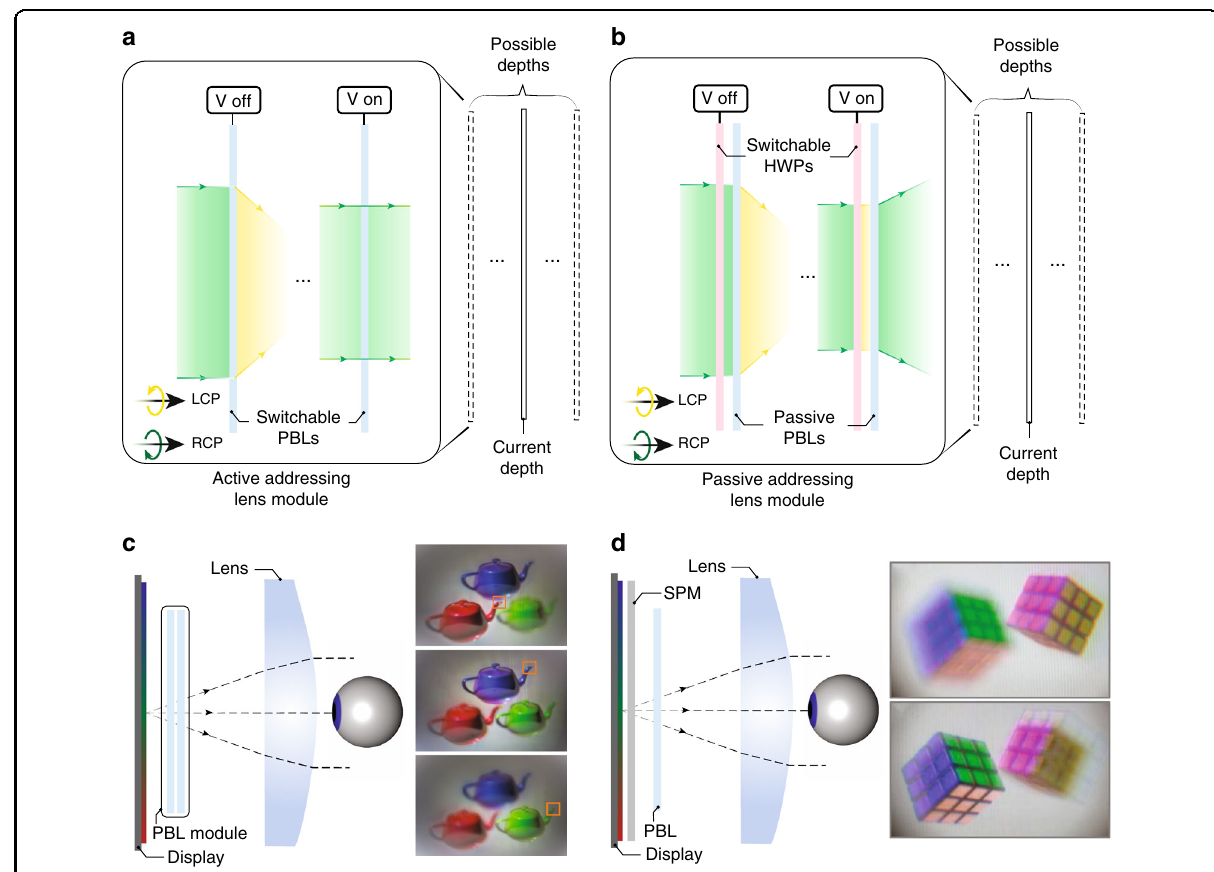
Fig. 6 Addressing VAC in VR. Working principles of a depth switching PBL module based on a active addressing and b passive addressing. c A four- depth multifocal display based on time multiplexing. d A two-depth multifocal display based on polarization multiplexing. Reproduced from c ref. 103 with permission from OSA Publishing and d ref. 104 with permission from OSA